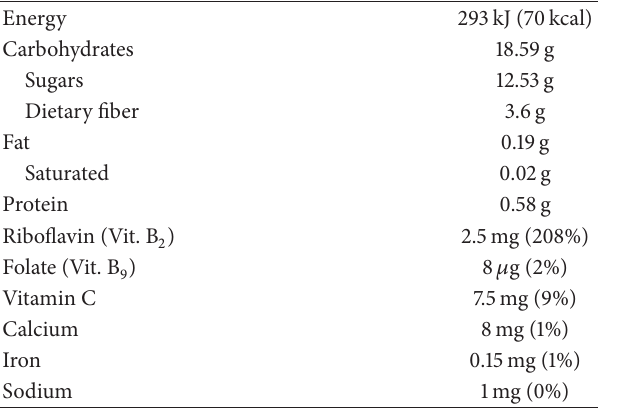
Table 1: Nutritional value a per 100 g (3.5 oz) of persimmon fruit ( Diospyros kaki , raw).